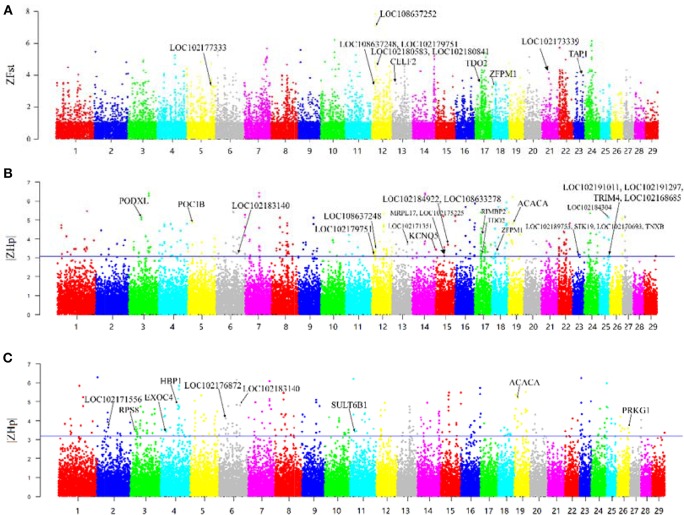
Overview of selective sweeps in the Nubian and Yunling black goat breeds based on ZFst and ZHp values. The labeled genes in bold characters represent those genes with selective signals that overlap with ASE genes. (A) ZFst values between Nubian and Yunling black goat breeds. Bold names are the ASE genes contained in the maximum Z-Fst in the 100 kb window. (B) ZHp value of Nubian goats. Bold names are the ASE genes contained in the minimum |ZHp| group of Nubian goats in the 100 kb window. (C) ZHp value of Yunling Black goats. Bold names are the ASE genes contained in the minimum |ZHp| group of Yunling Black goats in the 100 kb window.